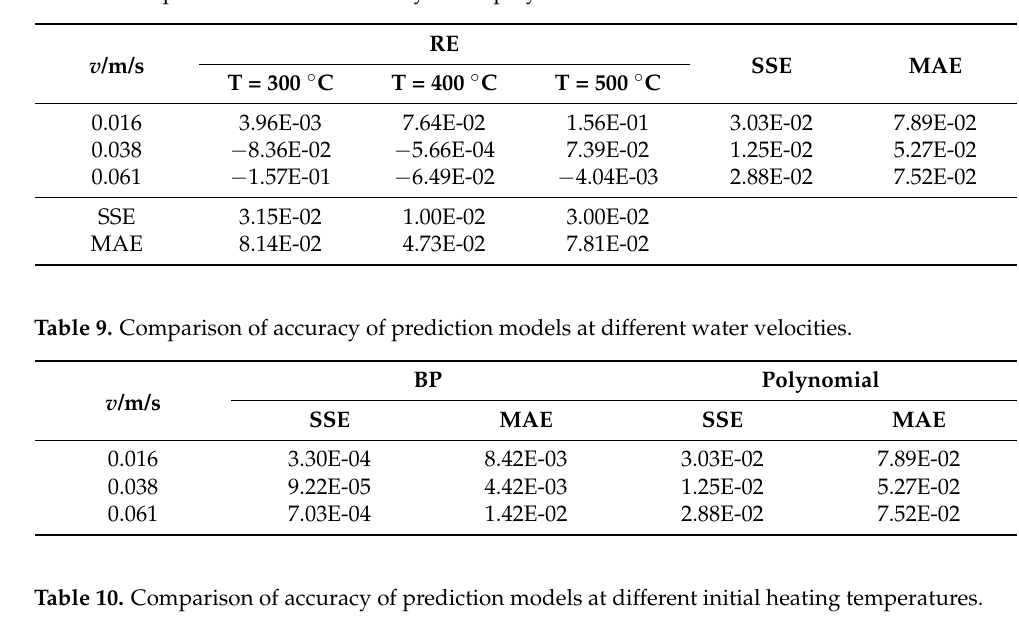
Table 10. Comparison of accuracy of prediction models at different initial heating temperatures. T